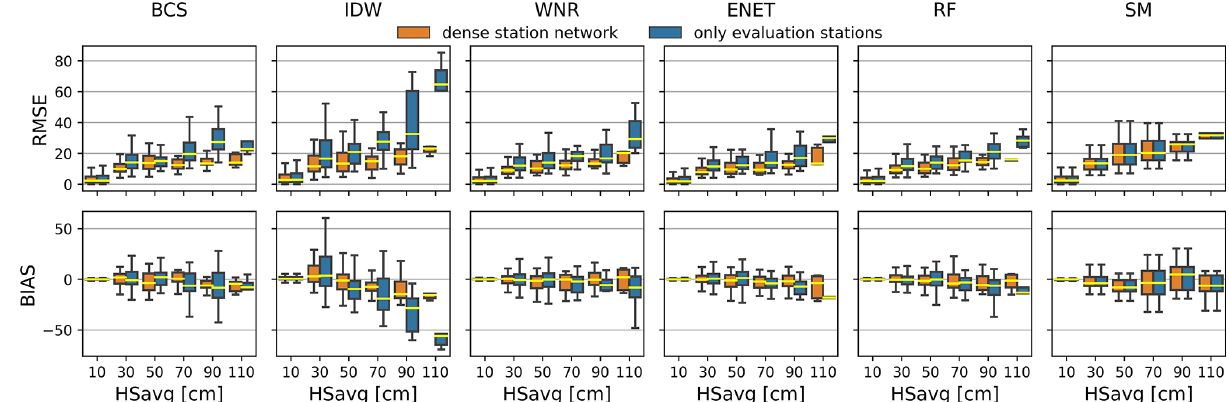
Figure A1. Box plots of RMSE (top row) and bias (bottom row) calculated for 20cm HSavg bins of the respective gap winter and the different methods (columns), respectively. Colors of the box plots denote the different station networks that have been used for reconstruction. Outliers in the box plots are not shown for better comparison. The maximum number of predictors for the different methods is set as defined in Table 1.